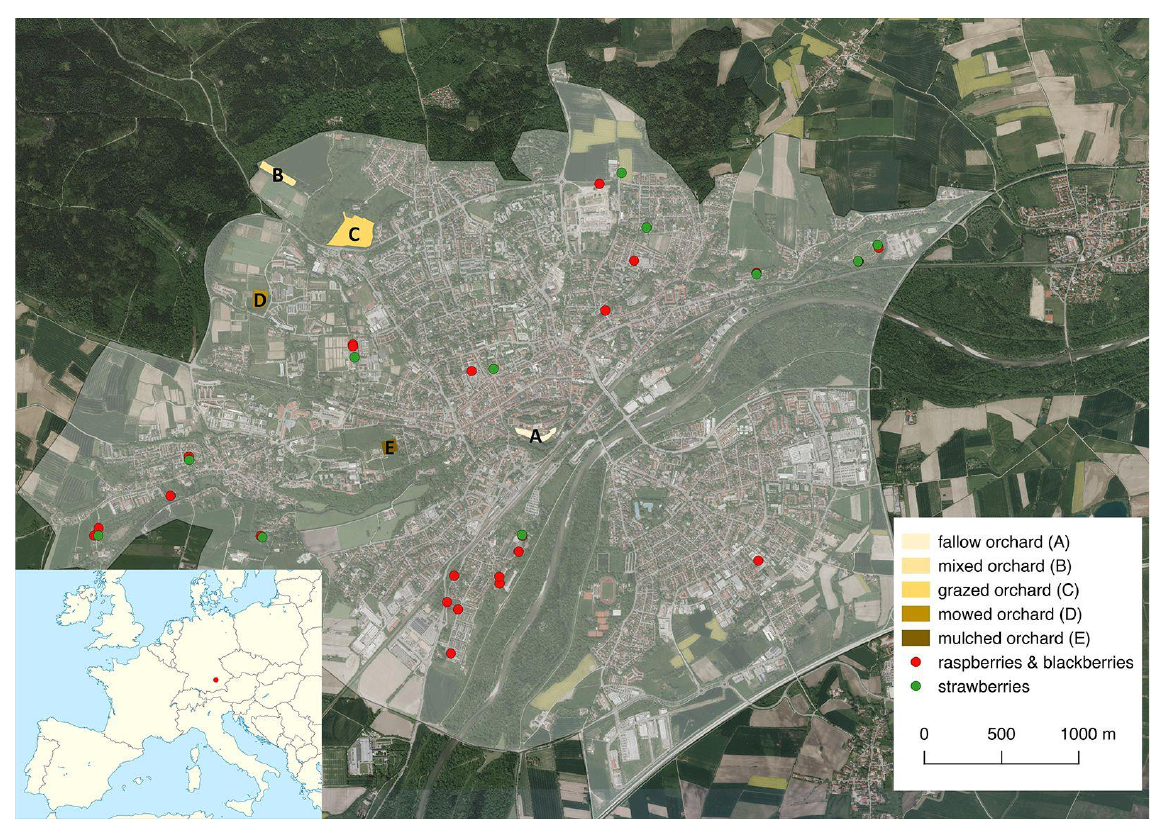
Figure 1. Study sites and management types (basemaps: Landesamt für Digitalisierung, Breitband und Vermessung (CC BY) & Wikimedia (CC BY-SA